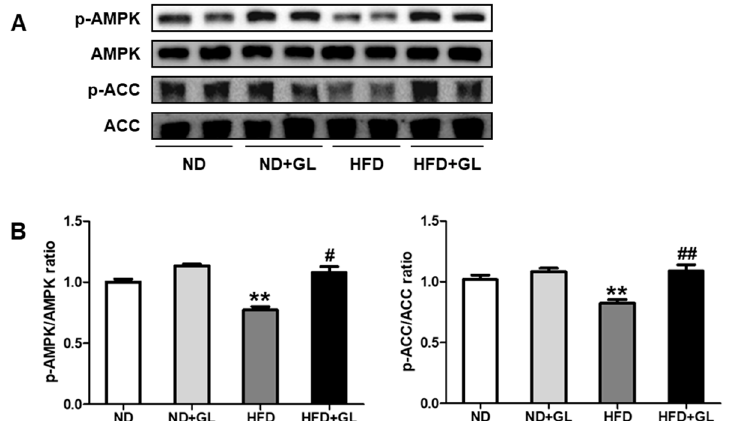
Figure 5. GL induced AMP-activated protein kinase (AMPK) and acetyl-CoA carboxylase (ACC) phosphorylation in HFD-fed mice. ( A ) Representative band images of Western blot analysis in